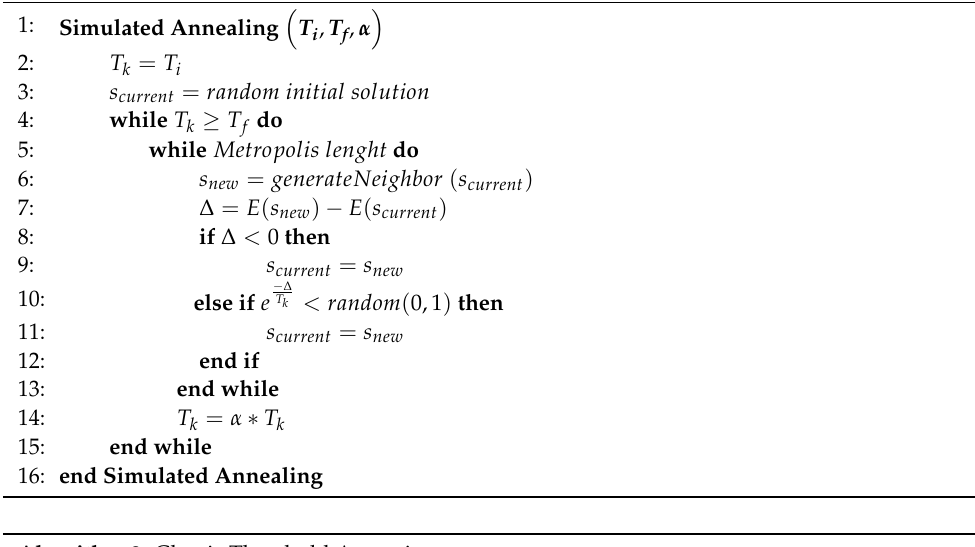
Algorithm 2. Classic Simulated Annealing